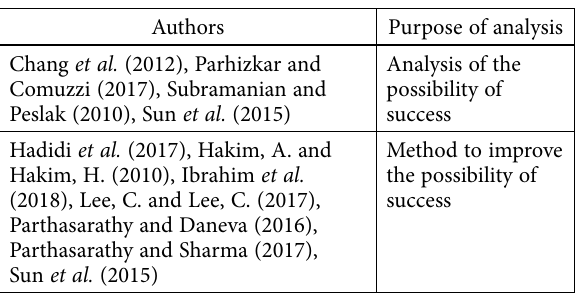
Table 4. Previous studies related to the possibility of success Authors Purpose of analysis